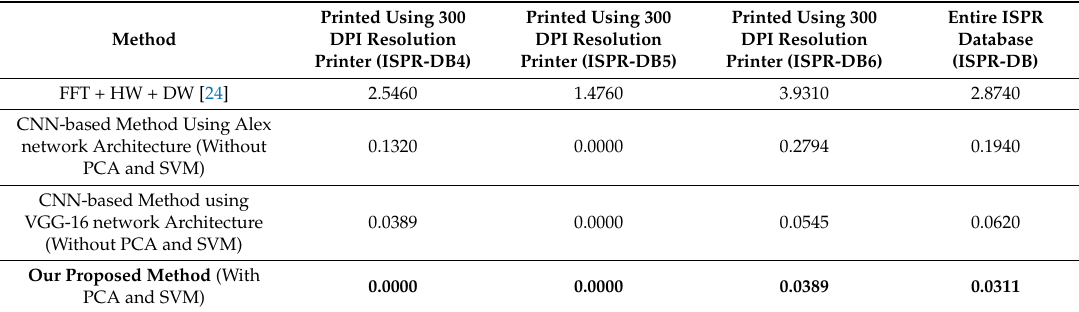
Table 21. Comparison of PAD errors of our proposed method and various methods using ISPR and its sub-databases (unit: